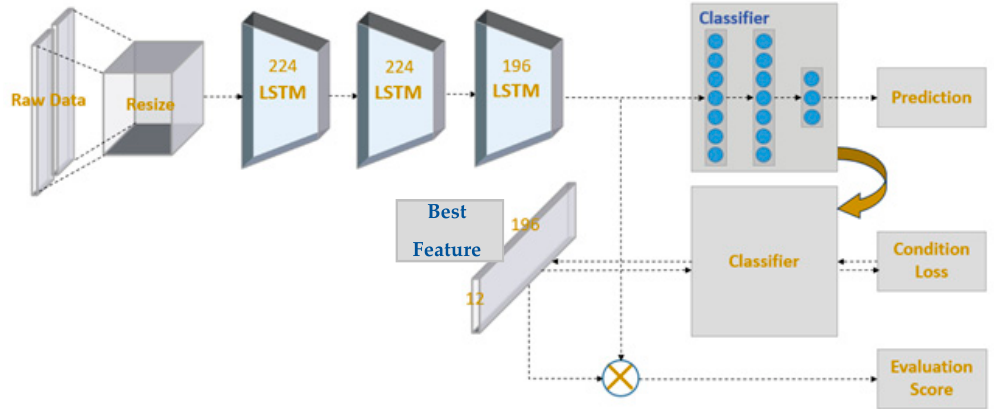
Figure 5. Model architecture for rehabilitation evaluation.